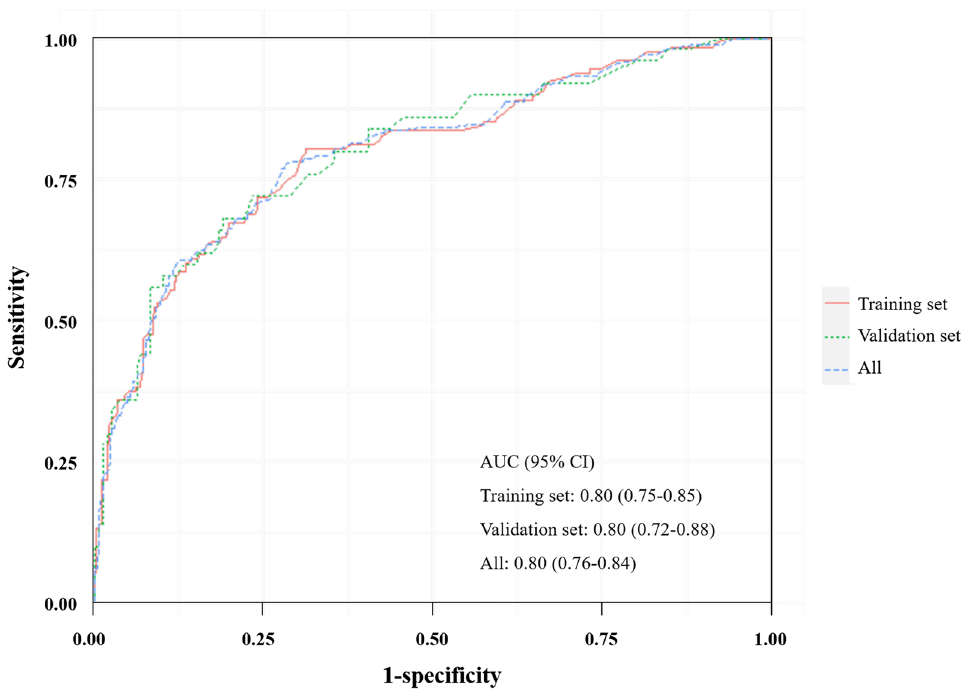
Figure 5. ROC curves for predictive model. The red line represents the ROC curve constructed based on the training set (n = 484); The green line represents the ROC curve constructed based on the validation set (n = 208); The blue line represents the ROC curve constructed based on the all population (n = 692). ROC curves were performed with ROCR (Sing et al. 2005).